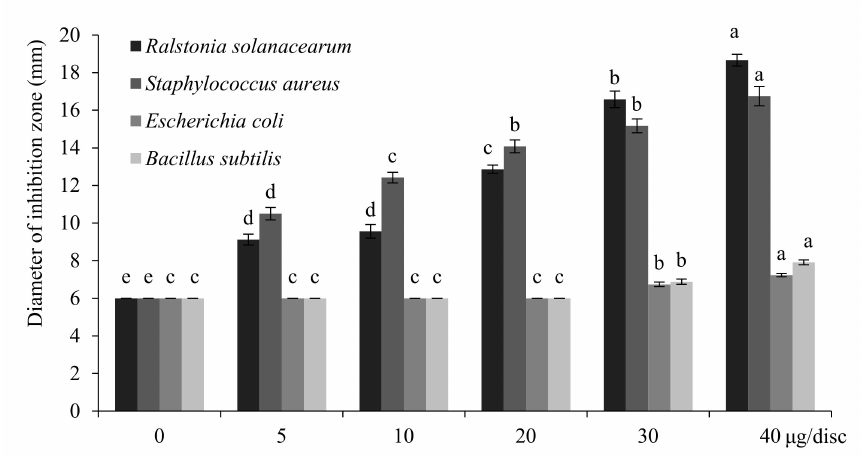
Figure 2. Antibacterial activity of T. flousiana essential oil estimated by diameter of inhibition zone. Diameter of inhibition zone includes diameter of discs (6 mm). Bacteria were cultured for 12 h at 37 ◦ C. Different letters represent values that differed significantly in the Duncan’s multiple range test ( p < 0.05).